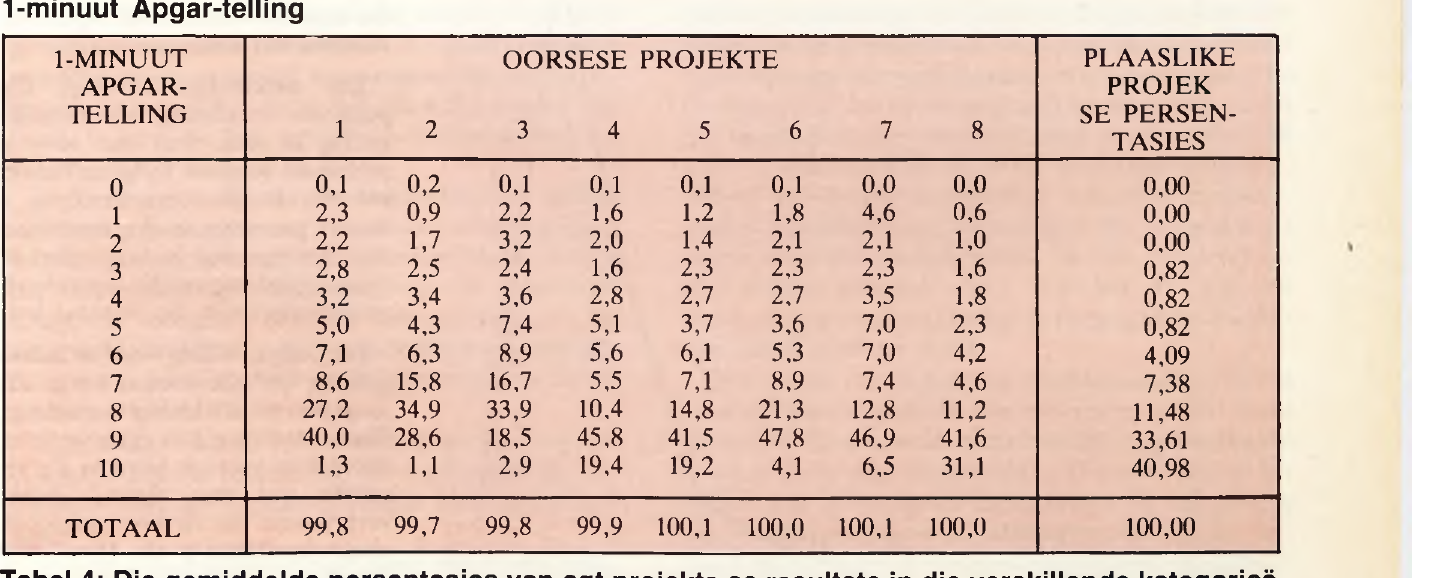
Tabel 4: Die gemiddelde persentasies van agt projekte se resultate in die verskillende kategorieë van die 1-minuut Apgar-telling APGAR-TELLING